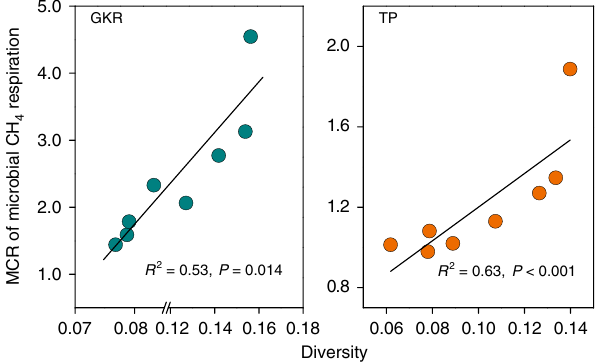
Fig. 4 Compensatory thermal responses in relation to shifts in the microbial community structure. The relationship between the magnitude of compensatory responses (MCR) of microbial CH 4 respiration and the β - diversity of the methanogenic community was tested by a linear mixed- effects model with thermal treatment (i.e., warming or cooling by 4 °C) as a random effect. GKR, the Great Khingan Range; TP, the Tibetan